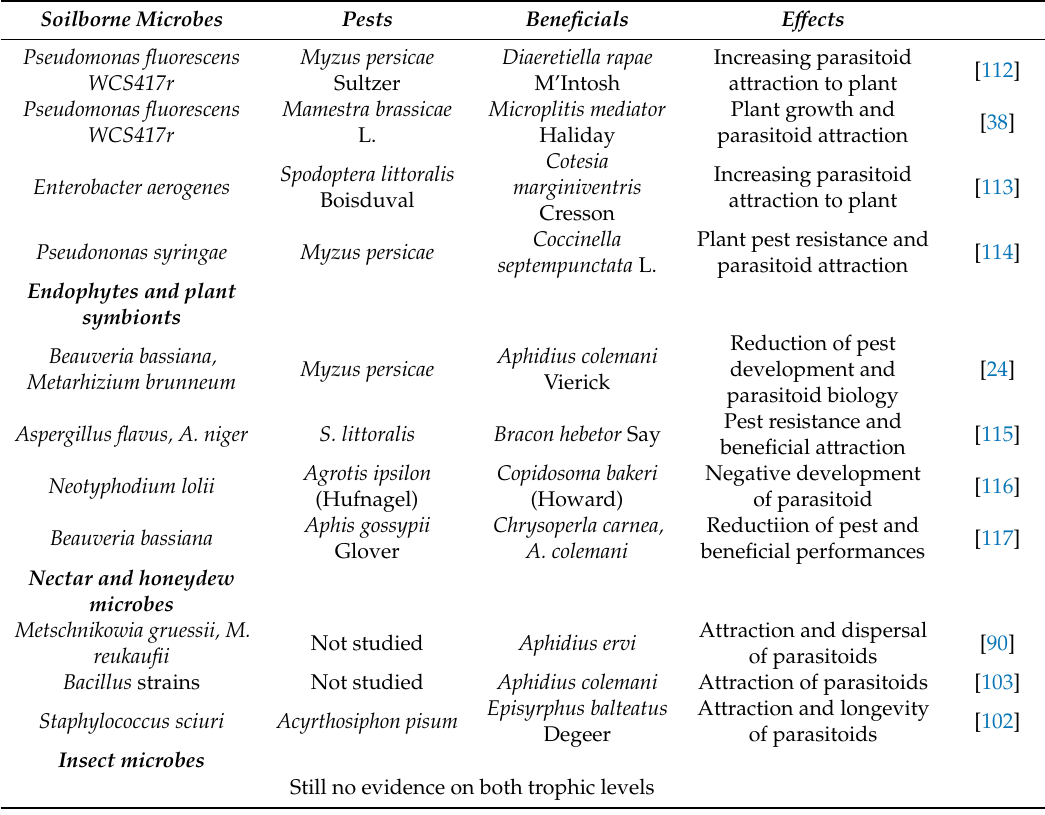
Table 1. Examples of case studies of tri-trophic interactions between microorganisms, herbivores and their natural enemies pointing out an indirect biocontrol e ff ect of